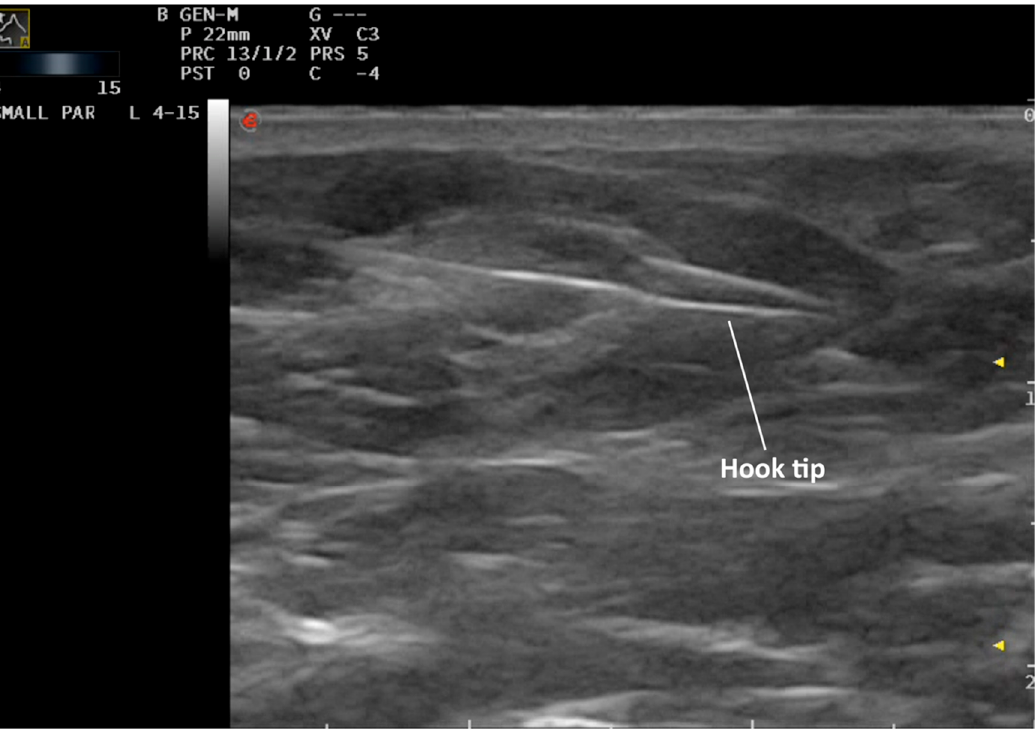
Figure 2. Ultrasound-guided hook-wire placement. From left to right: the figure shows the wire passing through the superficial inguinal lymph node and the hook tip close to the node.